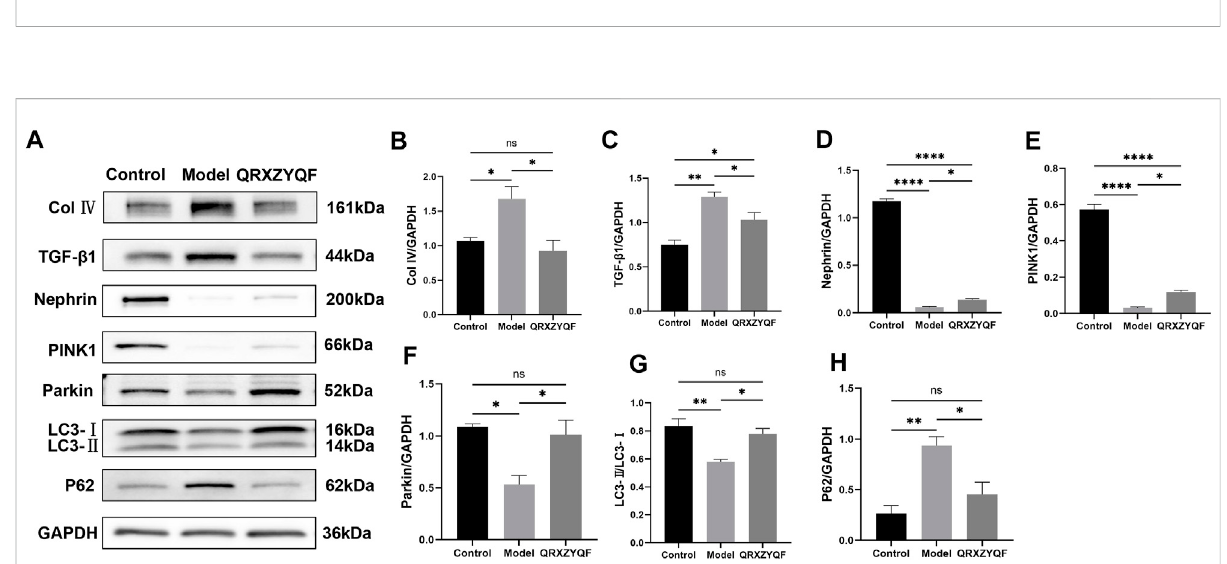
FIGURE 6 Western blot analysis of renal tissues. ns P > .05, * p < .05, ** p < .01, *** p < .001, **** p < .0001. (A) The band of Col Ⅳ , TGF- β 1, Nephrin, PINK1, Parkin,LC3andP62; (B) RelativeexpressionofCol Ⅳ ; (C) RelativeexpressionofTGF- β 1; (D) RelativeexpressionofNephrin; (E) Relativeexpressionof PINK1; (F) Relative expression of Parkin; (G) LC3-II/LC3-I ratio; (H) Relative expression of